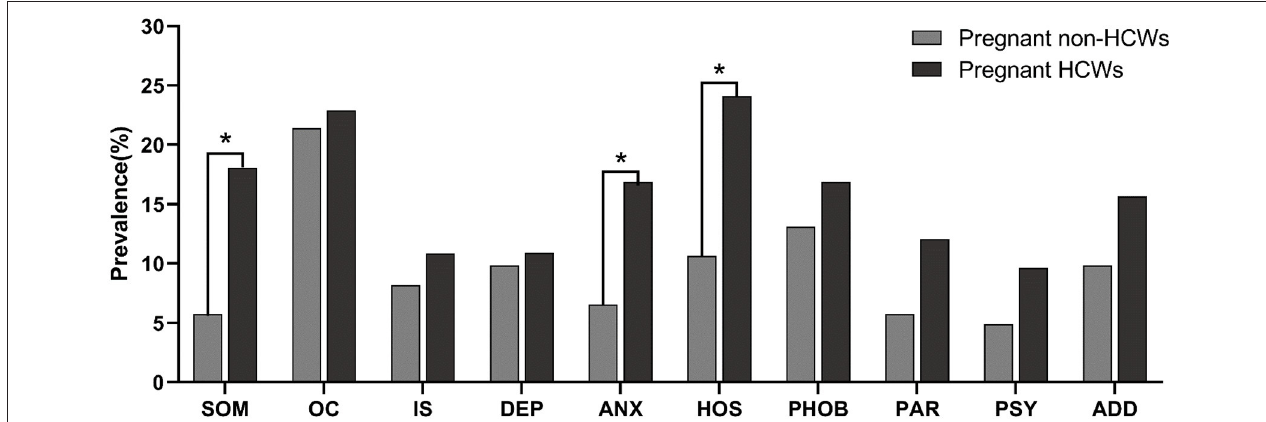
FIGURE 1 | The prevalence of psychological symptoms (factor score ≥ 2) between pregnant HCWs and pregnant non-HCWs. * p < 0.05, statistically significant results. SOM, somatization; OC, obsessive-compulsive symptoms; IS, interpersonal sensitivity; DEP, depression; ANX, anxiety; HOS, hostility; PHOB, phobic anxiety; PAR, paranoid ideation; PSY, psychosis; ADD, additional items.